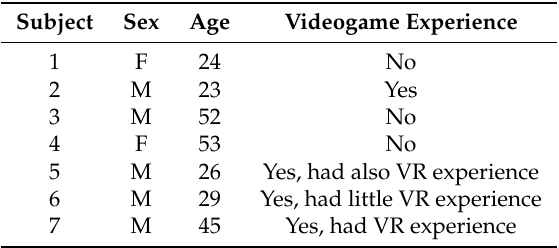
Table 1. Information about healthy subjects used for the tool baseline